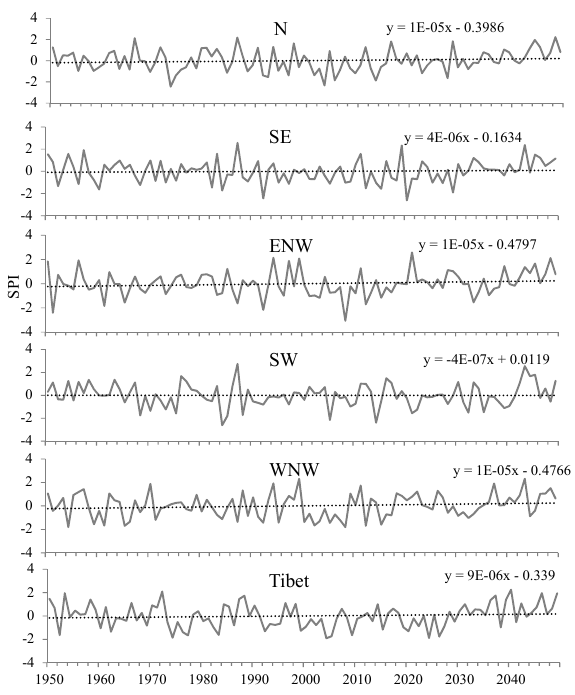
Figure 5. Sub-regions average time series of the SPI in drought from 1950 to